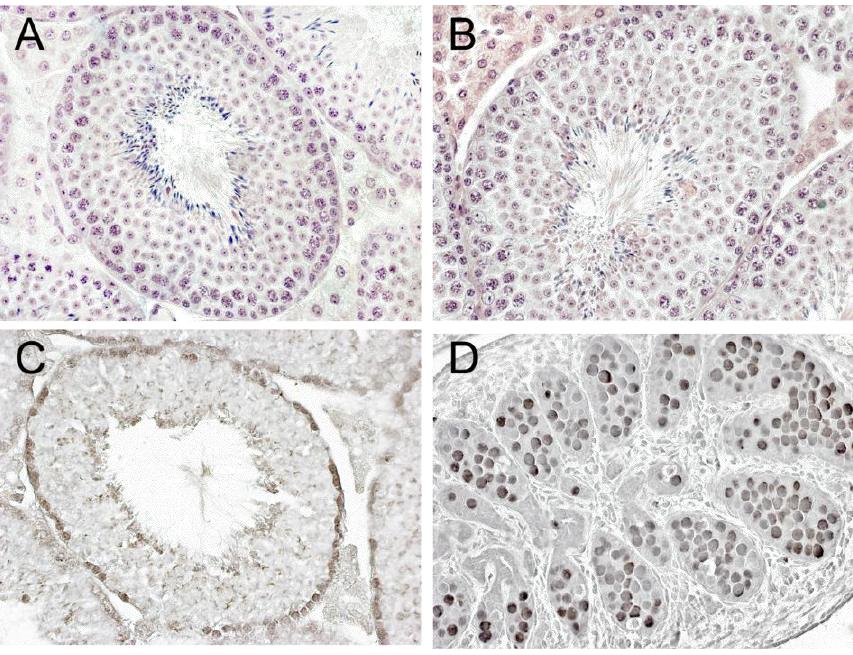
Figure 3. Testicular histology of fetal and adult TSPY transgenic mice ( Tg(TSPY)9Jshm ) and of an adult NMRI wildtype male. Hematoxylin and eosin staining of testis of an adult TSPY transgenic mouse (A) in comparison to an adult NMRI wildtype male (B) . Spermatogenesis and spermiogenesis of TSPY transgenic males were normal in comparison to wildtype mice. The TSPY specific antiserum 837/3 [15] immunostained spermatogonia and primary spermatocytes of the leptotene/zygotene stage in adult testes (C) and gonocytes and prespermatogonia in fetal gonads ( D , testis of the embryonal stage 14.5 dpc) of mice of the line Tg(TSPY)9Jshm . A-D, orginal magnification x400. An unspecific immunostaining of the acrosome of round spermatids is also